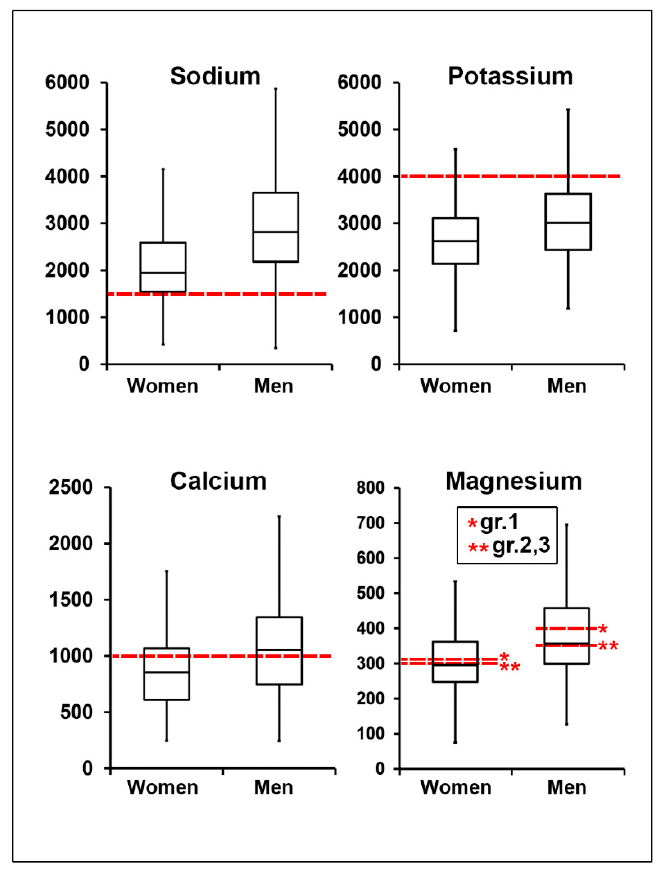
Figure 1. Median intake levels of sodium, potassium, calcium and magnesium in women and men, mg/day. Red dashed lines depict recommended intake levels for each electrolyte. For magnesium, red dashed lines depict reference values for different age groups: group 1 (one asterisk *gr.1) and group 2, 3 (two asterisks **gr.2, 3) accordingly.